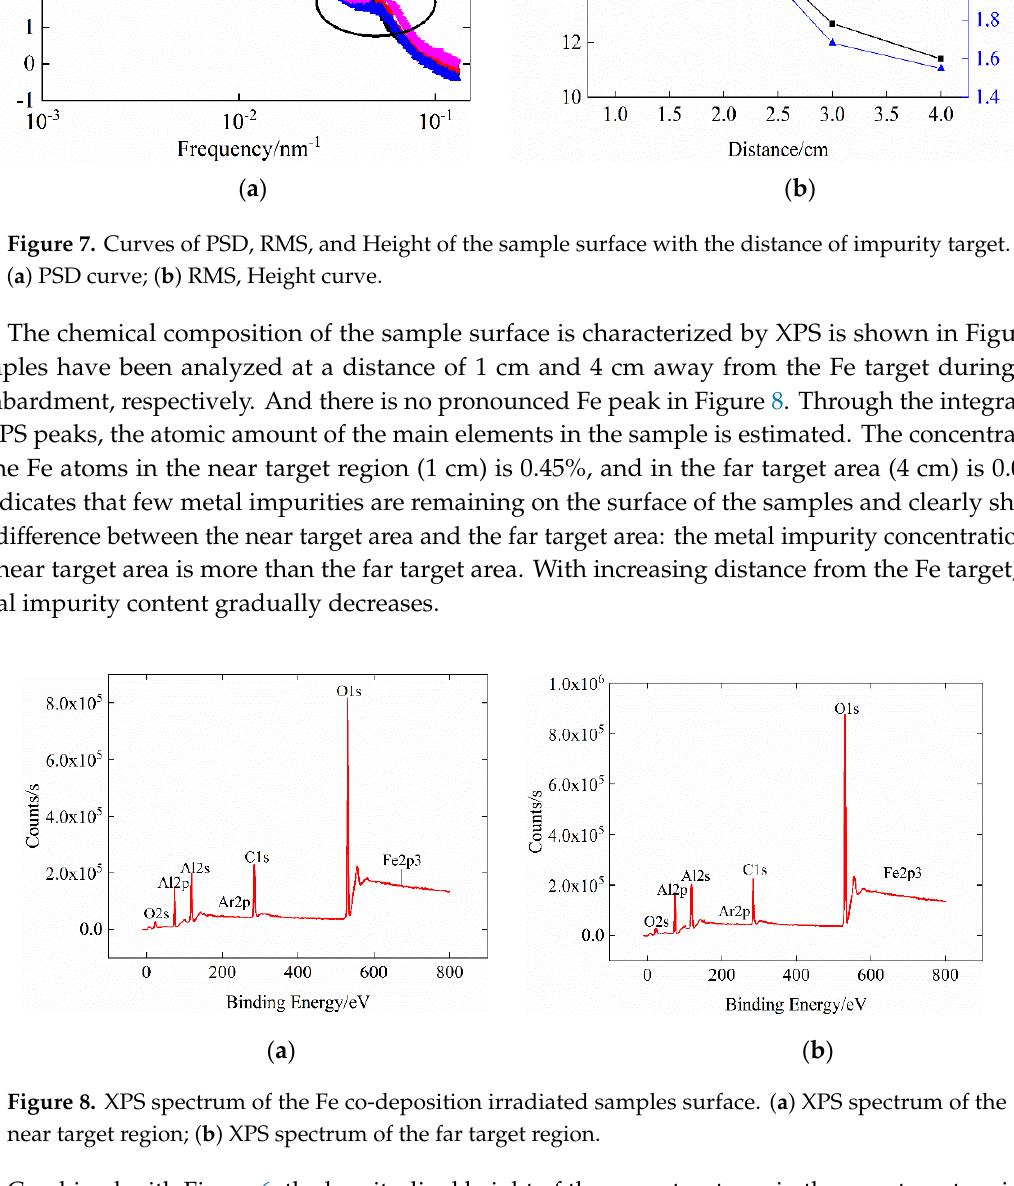
Figure 8. XPS spectrum of the Fe co-deposition irradiated samples surface. ( a ) XPS spectrum of the near target region; ( b ) XPS spectrum of the far target region.